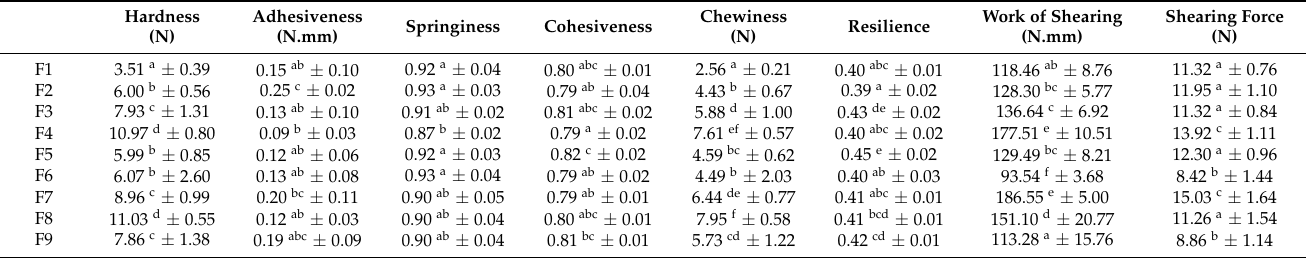
Table 3. The texture profile (TPA) and Warner–Bratzler analyses (values show mean ± standard deviation, n =